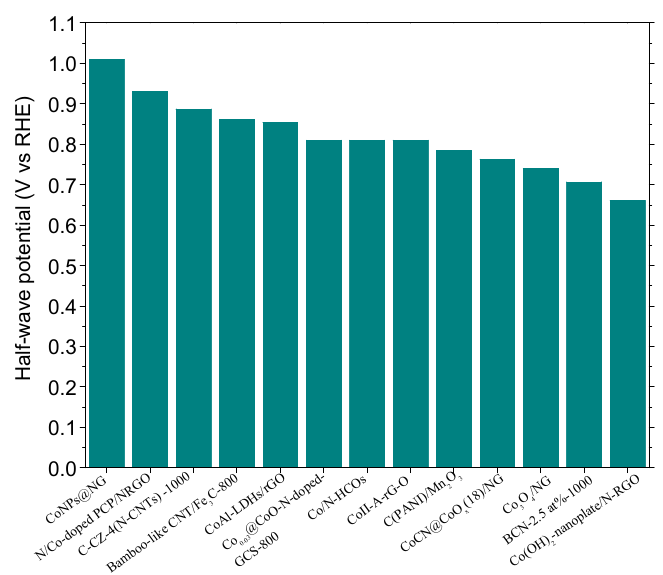
Figure 3. Comparison of half ‐ wave potentials. (References from left to right bar: [58], [53], [55], [56], [49], [47], [50], [51], [59], [54], [57], [48], [52]).